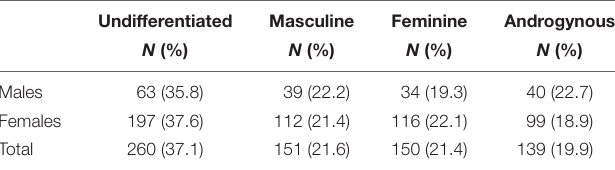
Undifferentiated Feminine